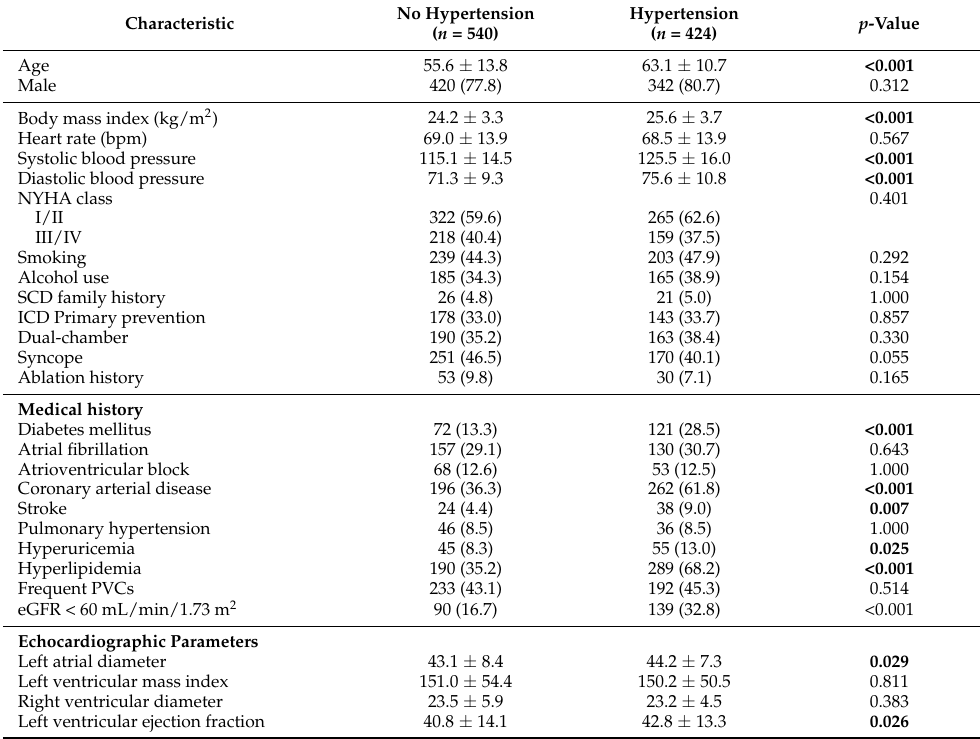
Table 1. Baseline Characteristics by Hypertension diagnosis in Patients with Chronic Heart Failure.